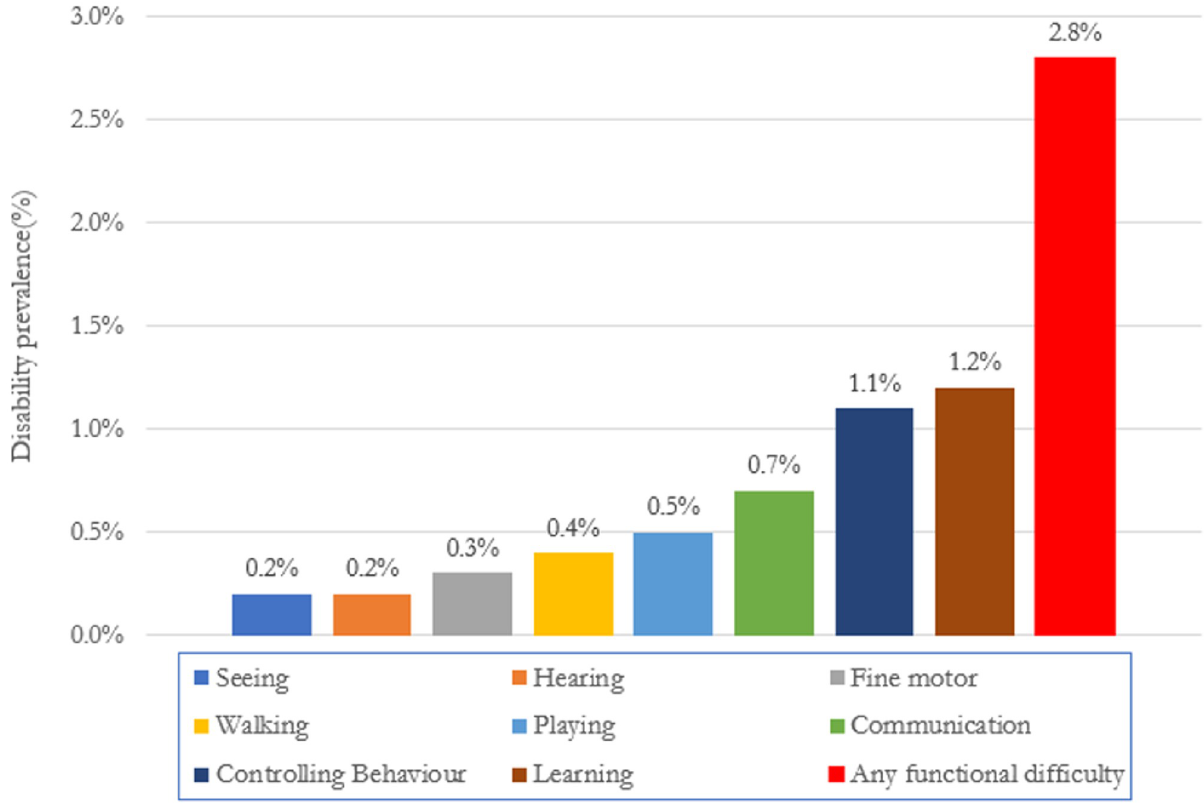
Fig 4. Functional difficulty in the individual domain (Source: [25]).